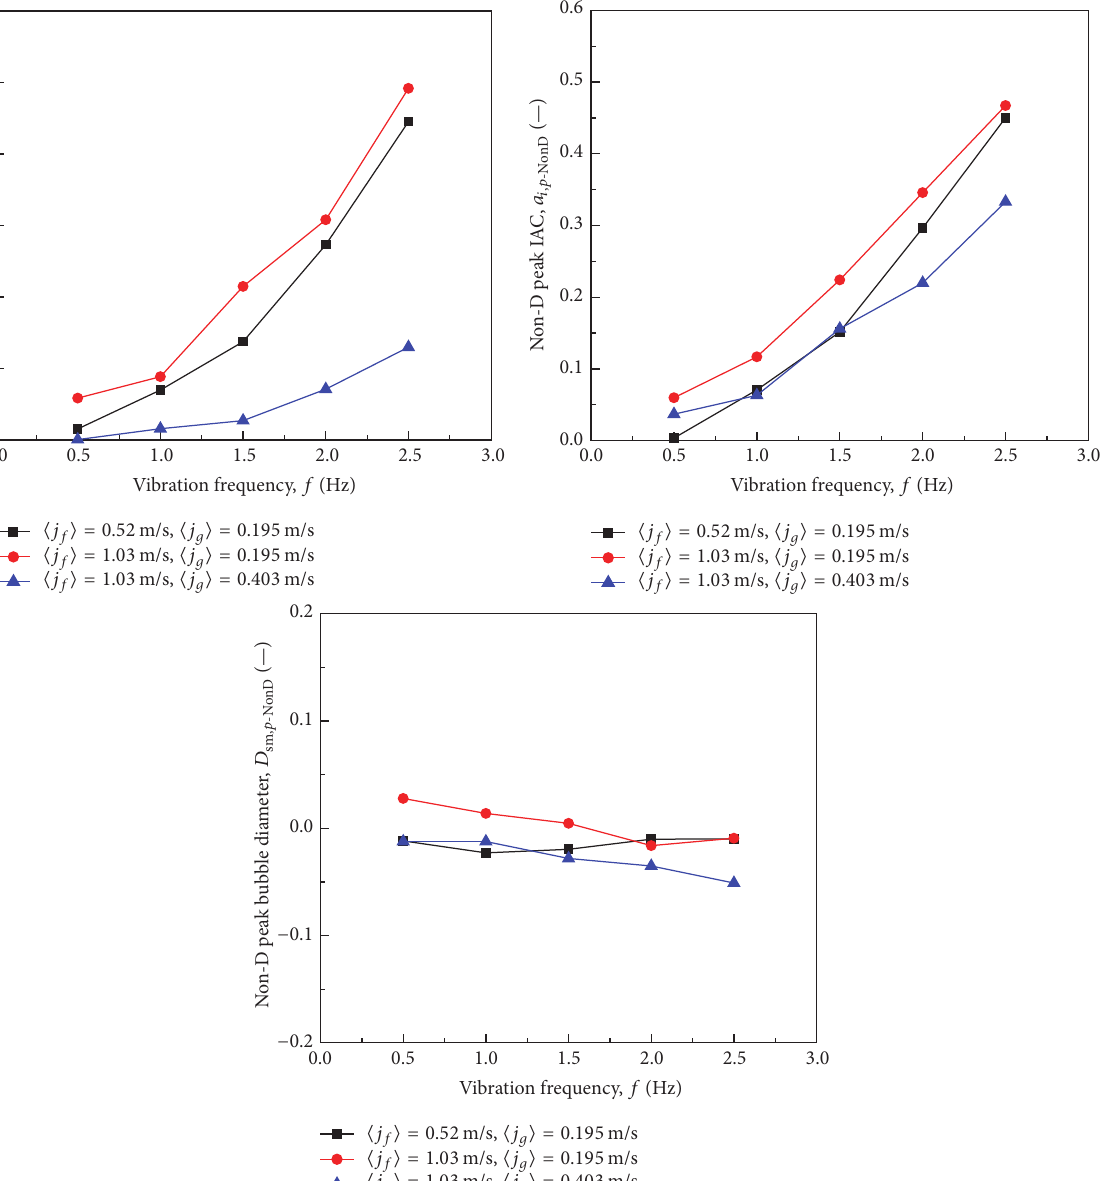
Figure 8: Vibration frequency effect on peak values of local flow parameters at 𝑆 = 𝑆 𝑚1